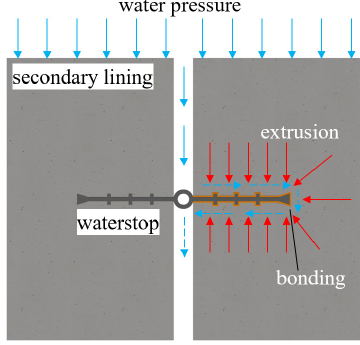
Figure 3. Water infiltration resistance of tunnel joints.